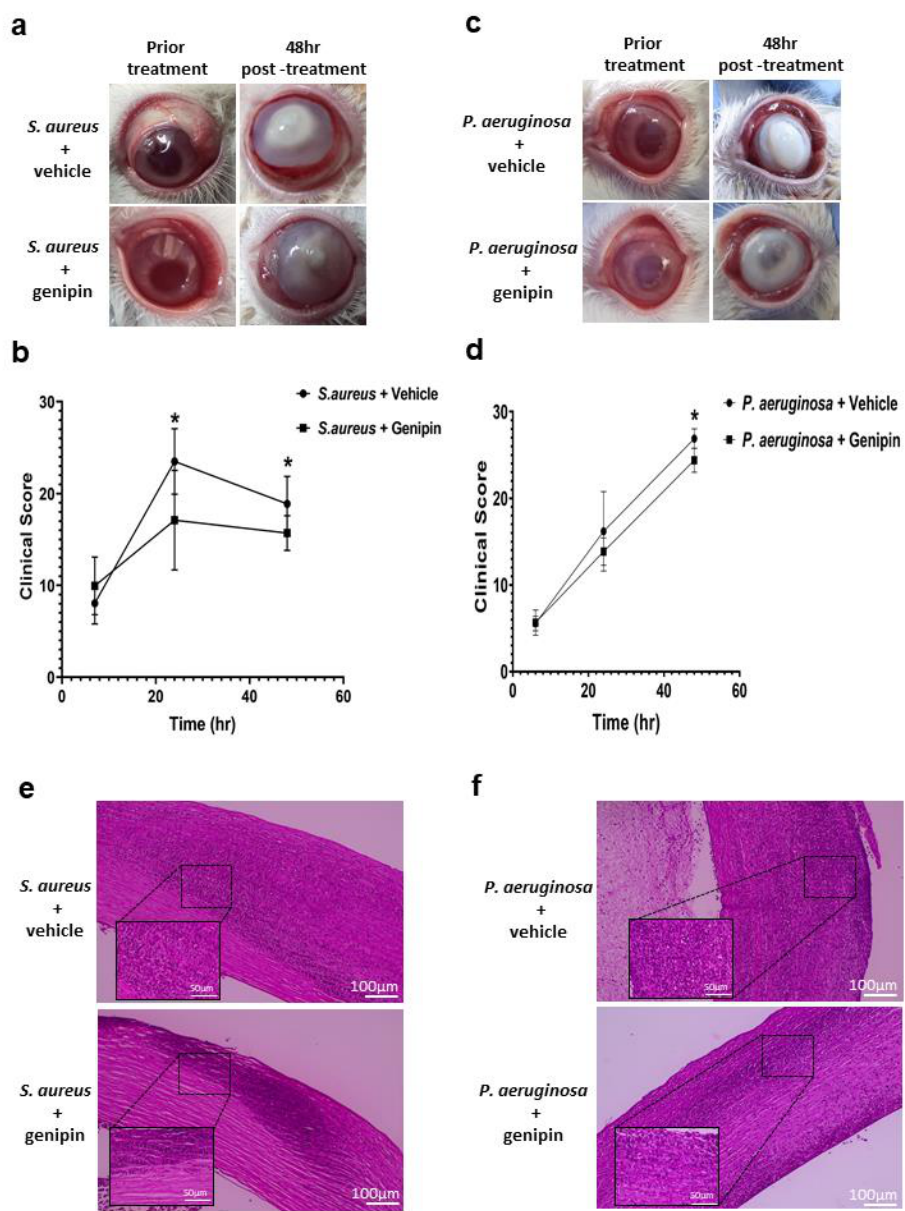
Figure 1. Genipin treatment ameliorates clinical manifestations of bacterial keratitis and regulates inflammatory cell infiltration. ( a , c ) Ocular surface observation and examination. Representative photographs of corneas infected with Staphylococcus aureus (S. aureus) or Pseudomonas aeruginosa (P. aeruginosa) prior to treatment and 48 h post-treatment with either vehicle solution or genipin. ( b , d ) Clinical scores at different times after bacterial inoculation. The data are the mean ± standard deviation of the mean, n = 5, * Statistically significant, p ≤ 0.05. ( e , f ) Histological analysis of infected corneas. Hematoxylin and eosin staining were used to examine the pathological changes at 48 h post-treatment. Representative images of five corneas per group. Histopathological analysis of the vehicle-treated corneal tissue sections for both the S. aureus and P. aeruginosa keratitis showed that the corneal stroma was mainly homogenized with necrotic lamellae and significant cell infiltration at the site of infection (Figure 1e,f). Genipin-treated corneas observably showed reduced cell infiltrate and alleviated corneal edema (Figure